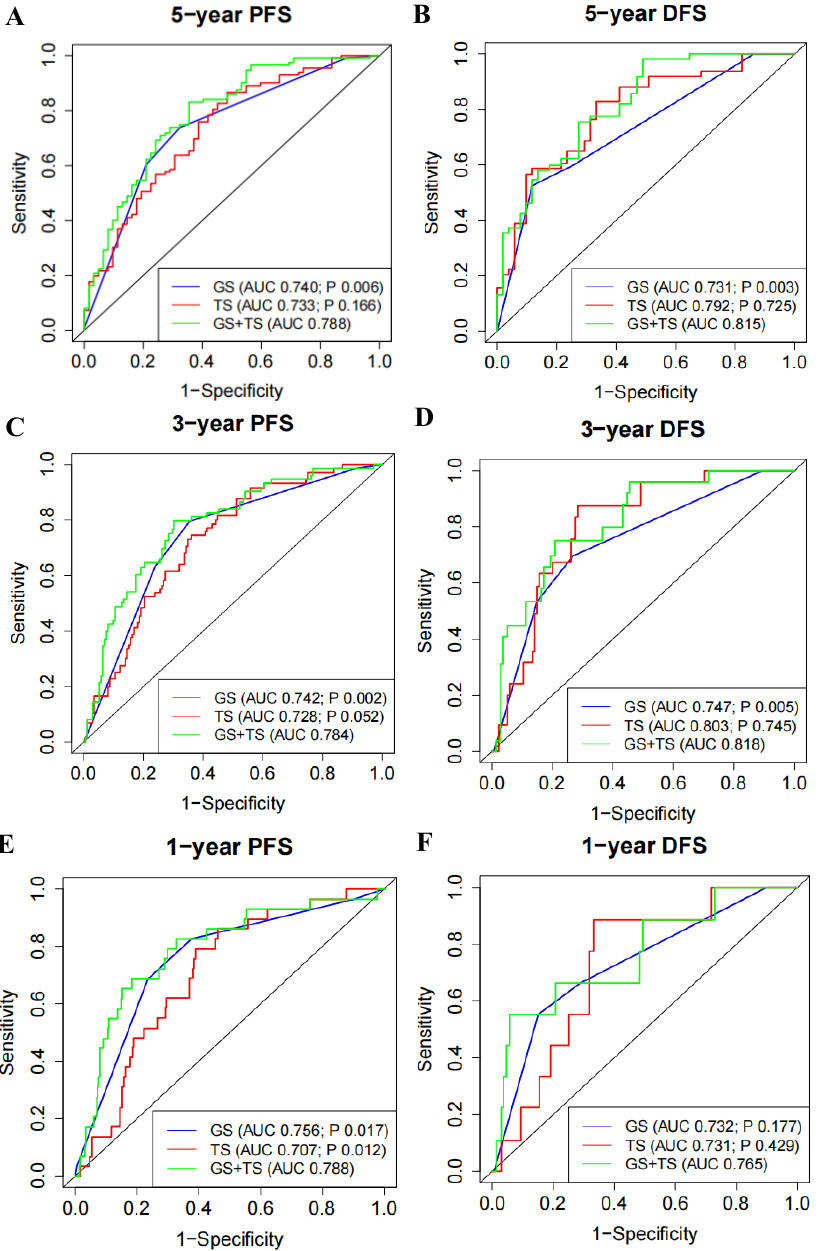
Figure 4. Expression of 5ʹ-tRFs provides additional PRAD prognostic information independent of Gleason score. ( A , C , E ) ROC curves to evaluate the prognostic performance of 5-year ( A ), 3-year ( C ), and 1-year ( E ) PFS, using TS, GS, or TS and GS. ( B , D , F ) ROC curves to evaluate the prognostic performance of 5-year ( B ), 3-year ( D ), and 1-year ( F ) DFS, using TS, GS, or TS and GS. Bivariate prognostic models of GS and TS (i.e., GS and TS) were compared with univariate prognostic models to assess whether TS or GS could provide independent prognostic information. p value less than 0.05 indicates that the performance of the bivariate prognostic models of GS and TS (i.e., GS and TS) is significantly better than that of the univariate prognostic model. TS: tRF score; GS: Gleason score.